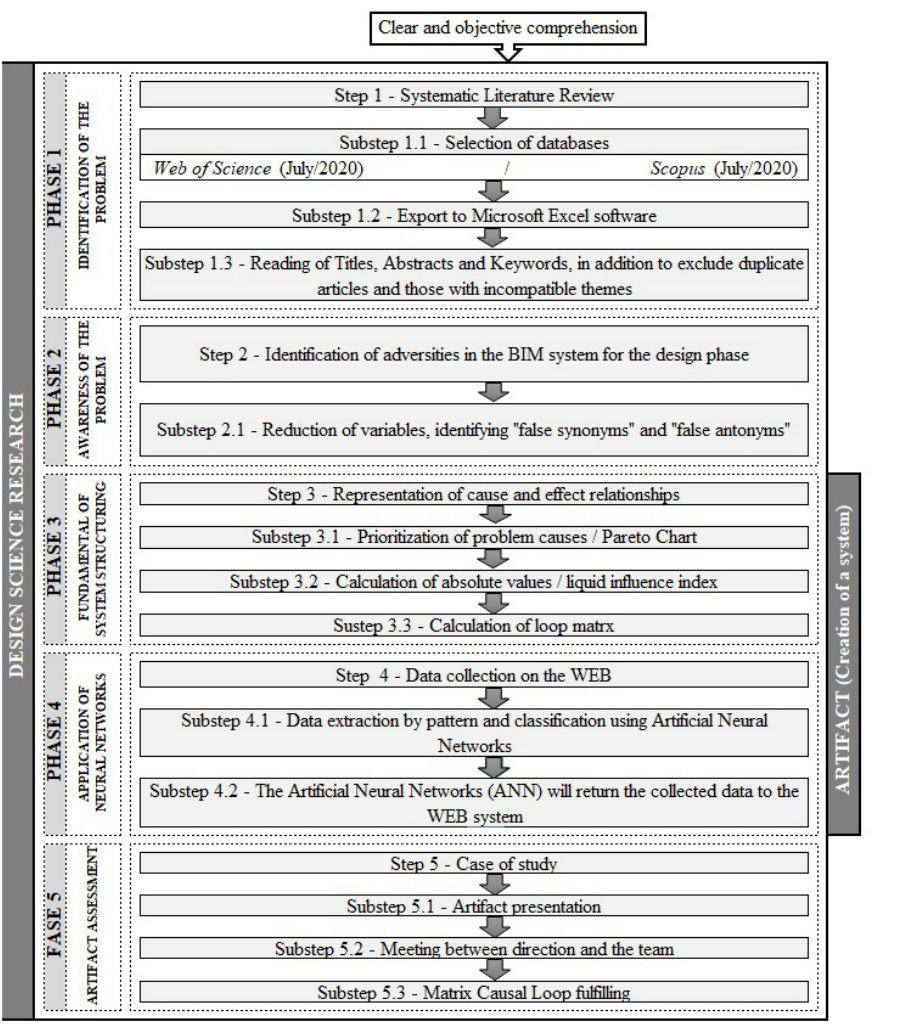
Figure 1. Structural organization of the workflow.